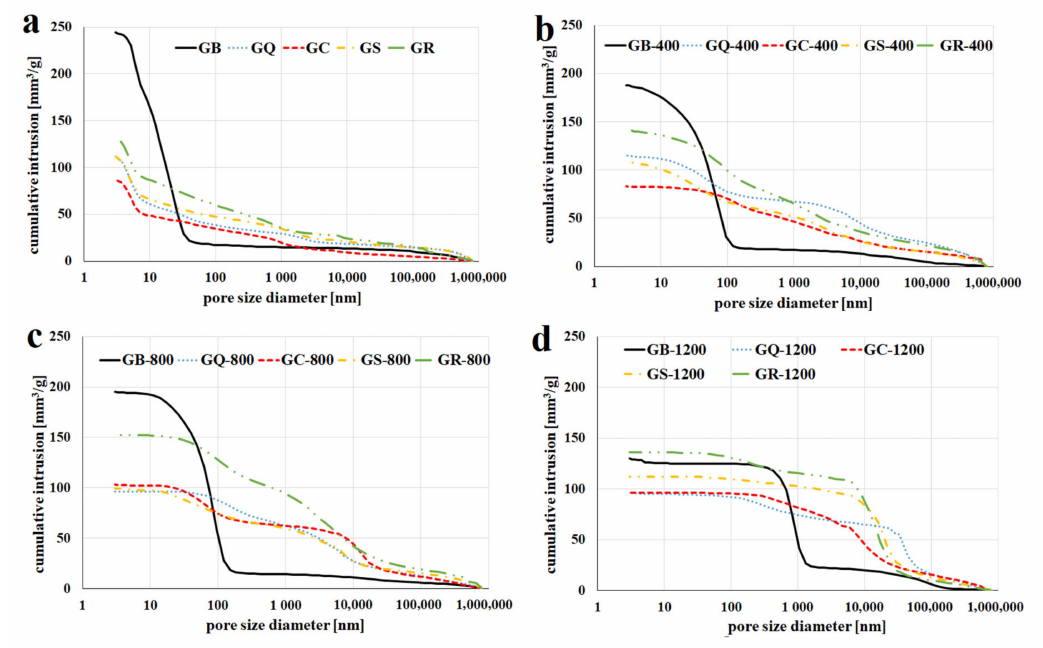
Figure 10. Mercury intrusion porosimetry of the geopolymer binder and geopolymer composites at room temperature ( a ) and after exposure to 400 ( b ), 800 ( c ), and 1200 ◦ C ( d ).